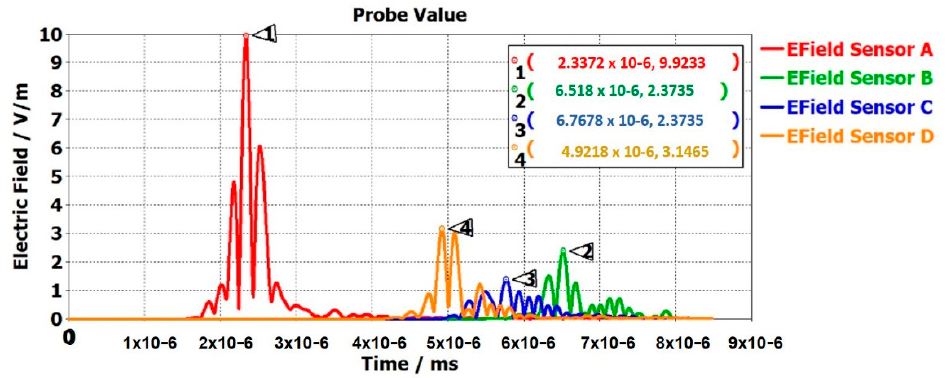
Figure 9. Efield of multi-sensor static digital model in CST Studio.